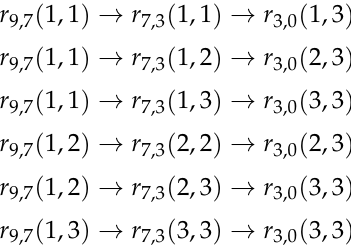
Figure 3. Schematic of the correlation of the road network.